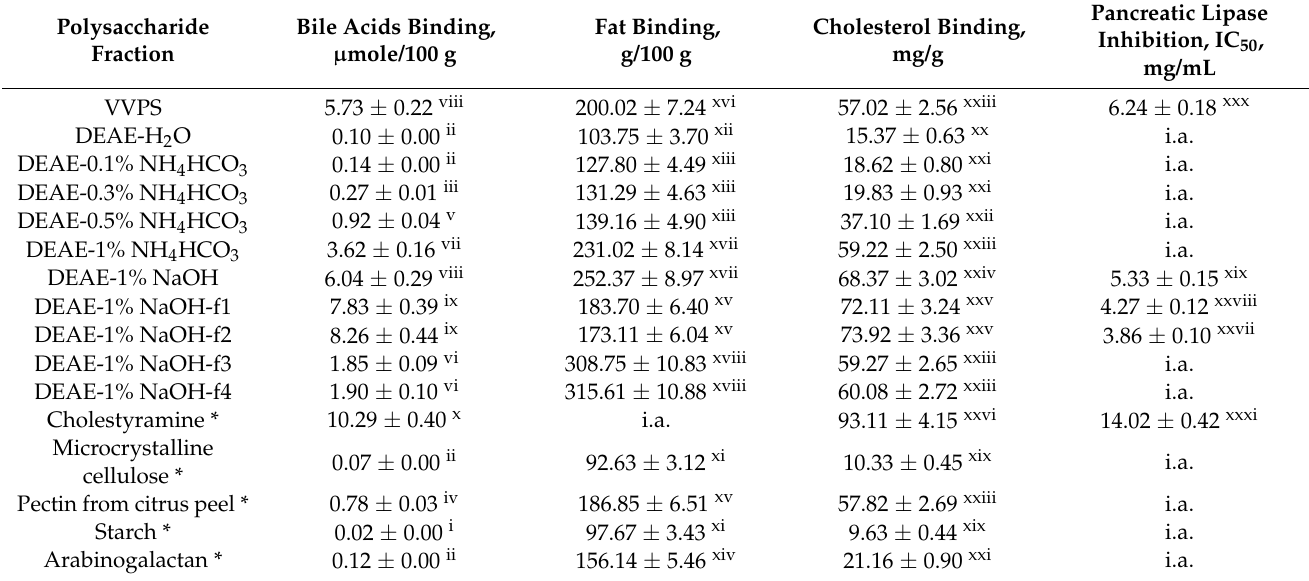
Table 5. In vitro hypolipidemic activity of VVPS, DEAE–cellulose and DEAE–sepharose fast-flow gel fractions ( n = 5).